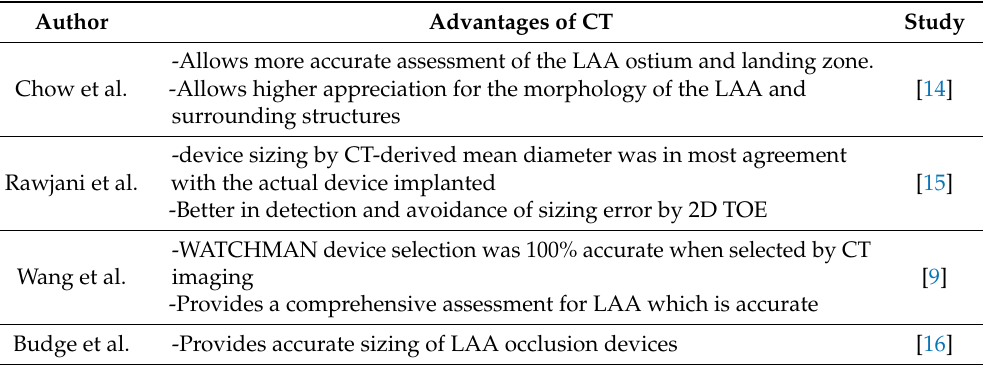
Table 3. Advantages of CT when assessing the left atrial